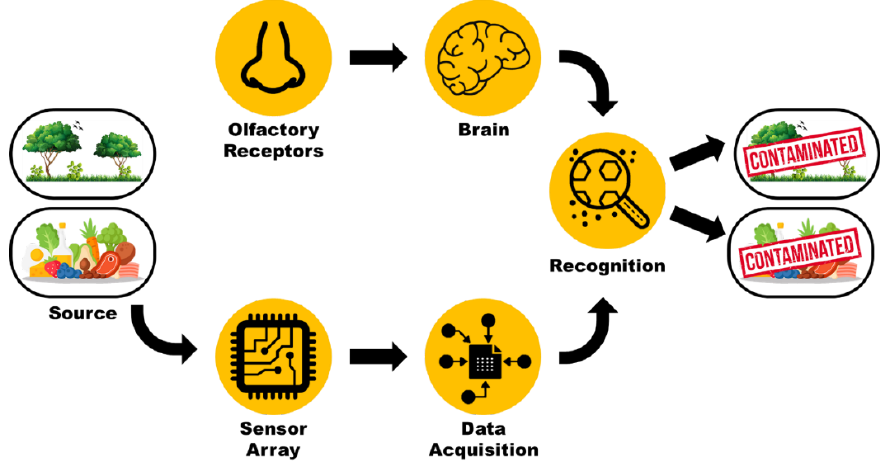
Figure 1. Schematic representation of the similarities between a mammalian olfactory system and an Enose.